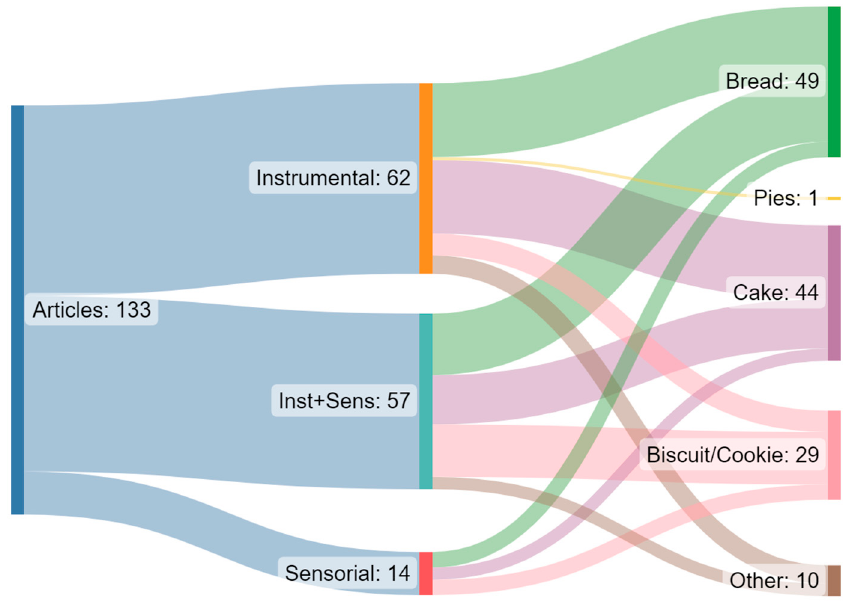
Figure 5. Sankey diagram of the studies included in the review considering the type of test and product.